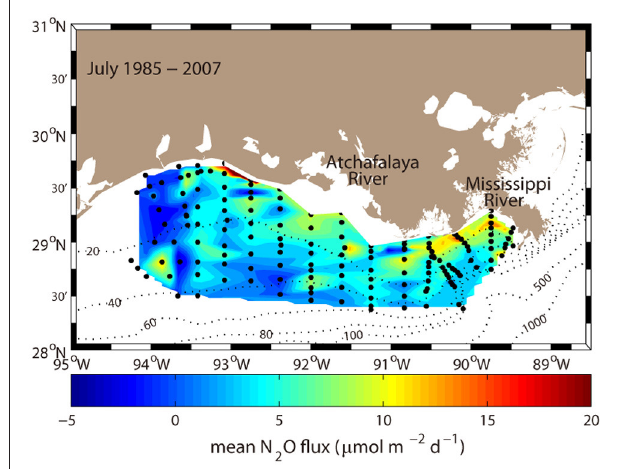
FIGURE 1 | Spatial distribution of the July mean N 2 O flux averaged from 1985 to 2007 (excluding 1988–1990) with the bathymetry contours (black dotted lines; unit of meters) in the nGOM. Black dots indicate the hydrographic stations used in our